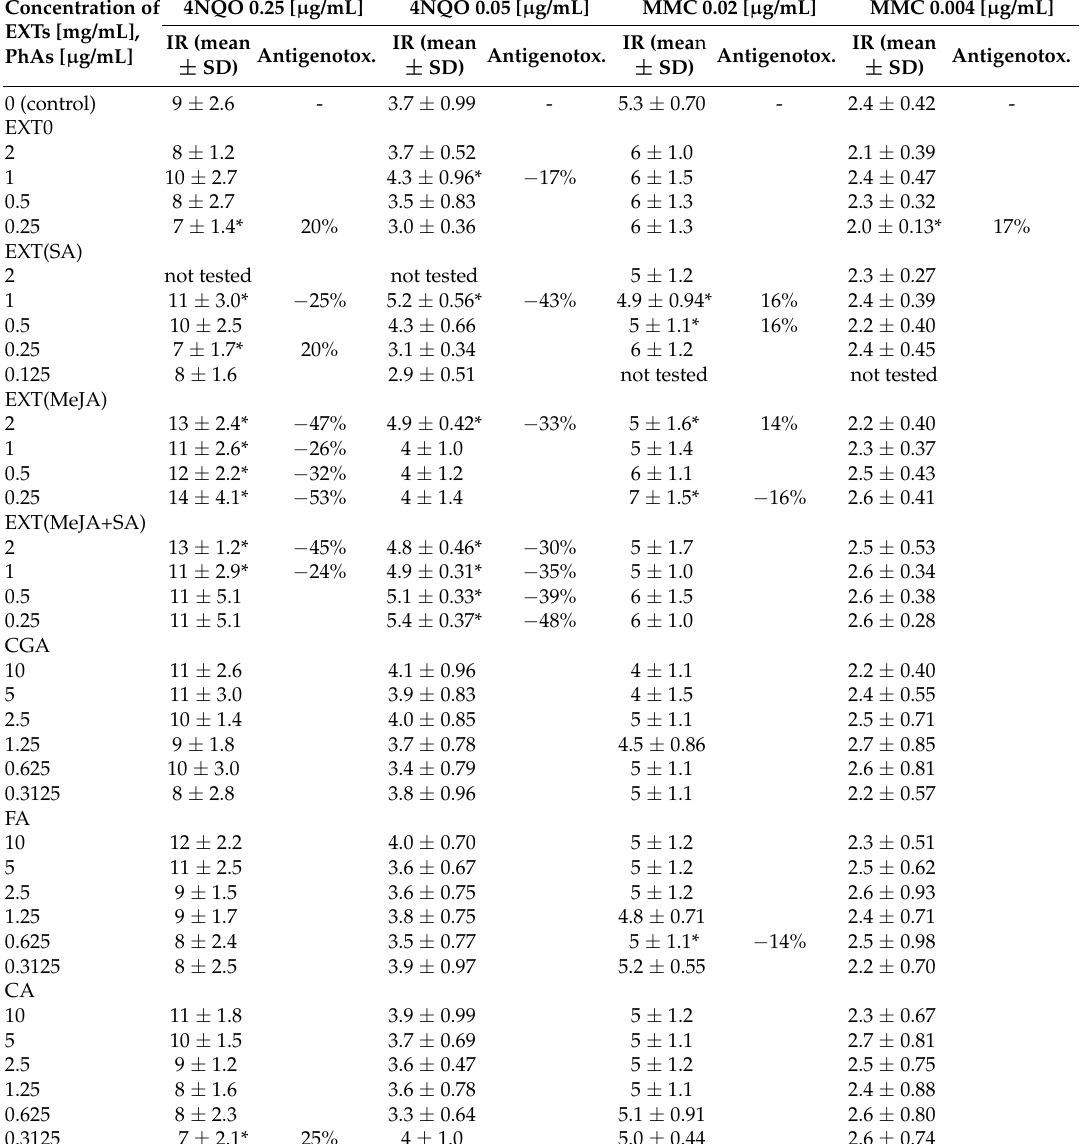
Table 4. Evaluation of antigenotoxic activity based on IR values for the control—genotoxins 4-nitroquinoline-N-oxide (4NQO) and mitomycin C (MMC)—and the mixture of genotoxins with the tested